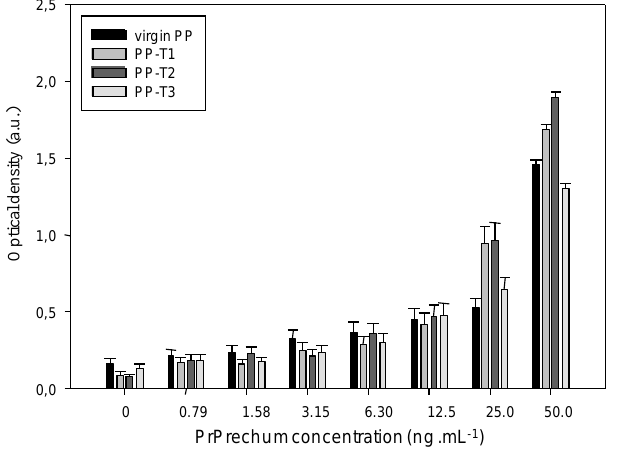
Figure 1. Dependence of the detection of PrPrechum protein on its concentration and